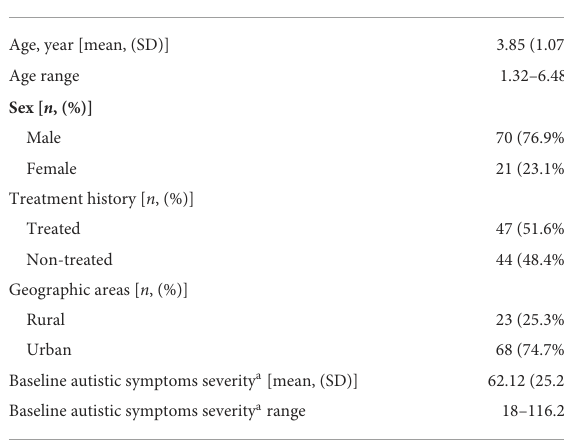
TABLE 3 Demographics of children and caregivers participating CST-Taiwan at the promotion